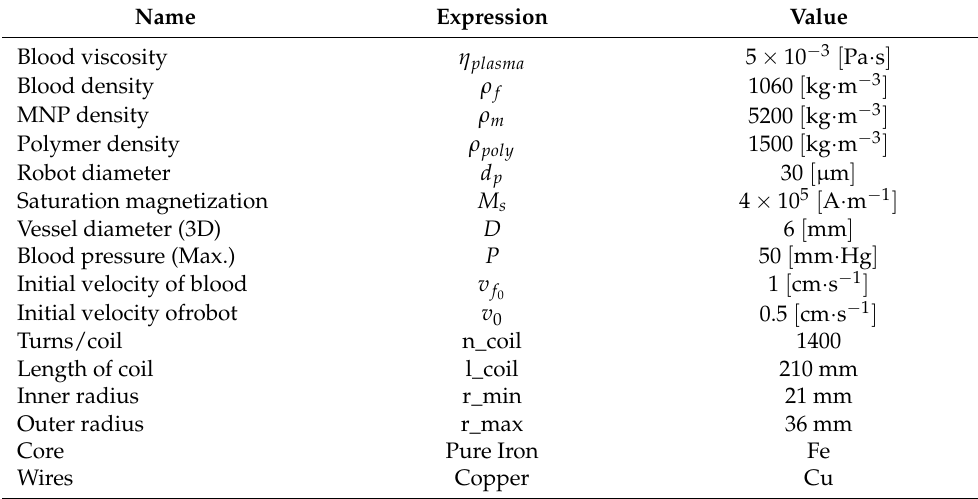
Figure 4. Particle trajectories under the influence of 𝛻𝐵 . ( a ) FFP positioned at top left corner ① ; 𝛻𝐵 has two components: 𝛻𝐵 𝑥 forces microrobots toward right bifurcation and 𝛻𝐵 𝑦 acts downward, decelerating and allowing microrobots to linger with 𝛻𝐵 𝑥 . ( b ) FFP positioned at lower left corner ③ ; compared with to ① , 𝛻𝐵 𝑦 here is upward, accelerating the particles upward and leaving less time with 𝛻𝐵 𝑥 (hence, it is less efficient). 3.2. 3 D Case